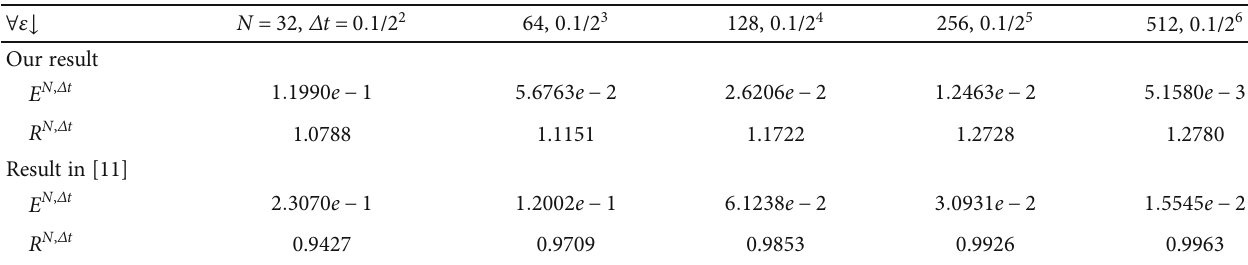
Table 3: Comparison of ε -uniform values for λ = 0 : 99 using the proposed method and fi nite di ff erence method.